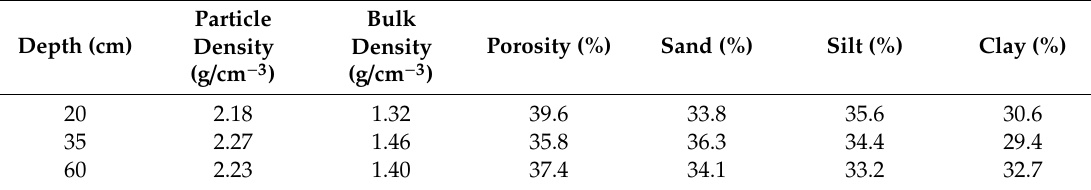
Table 1. Physical properties of field soils at di ff erent depths based on three undisturbed samples collected at each